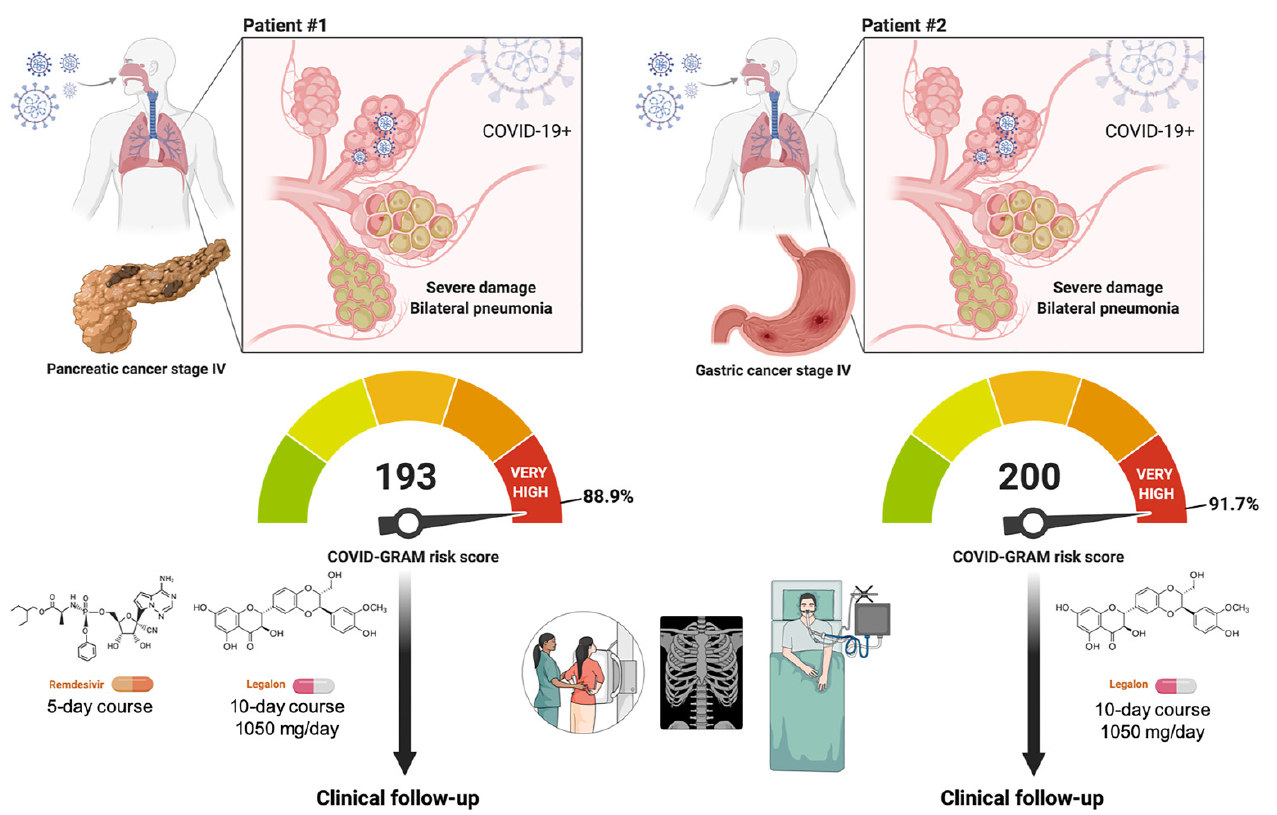
Figure 5. Clinical management of COVID-19 in hospitalized cancer patients with the STAT3i silibinin: two case reports. Both patients had SARS-CoV-2 bilateral interstitial pneumonia and a high COVID-GRAM score (i.e., 193 and 200 are the points scored in the COVID-GRAM Critical Illness Risk Score Tool by patient #1 and #2, respectively) [33–35]. Both patients were, therefore, predicted to be at high risk of critical COVID-19 illness in terms of intensive care unit admission, invasive ventilation, or death. In addition to physician’s choice of best available therapy (e.g., remdesivir) or supportive care (e.g., prophylactic anticoagulation with heparin), patients received 1050 mg/day Legalon ® for 10 days without side-effects. Created with